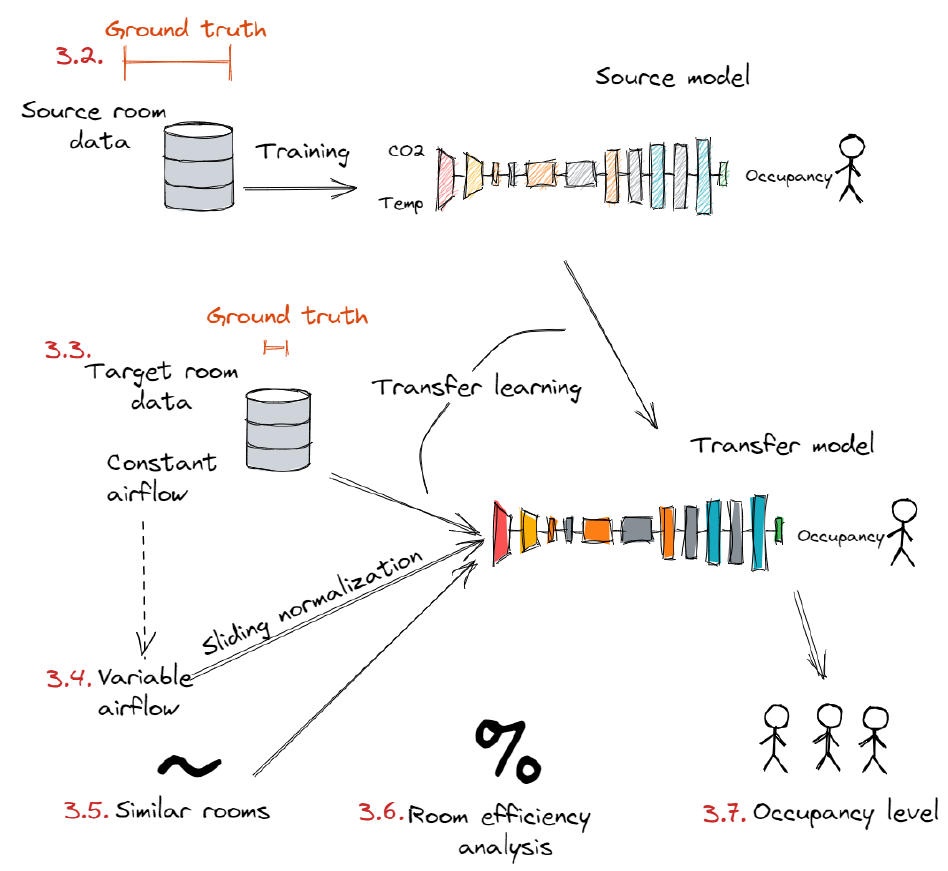
Figure 4. Workflow of the paper: Training of source occupancy prediction model, transferring the model, change of ventilation system operation (robustness check), using target model with similar rooms, room efficiency analysis and transfer of occupancy level